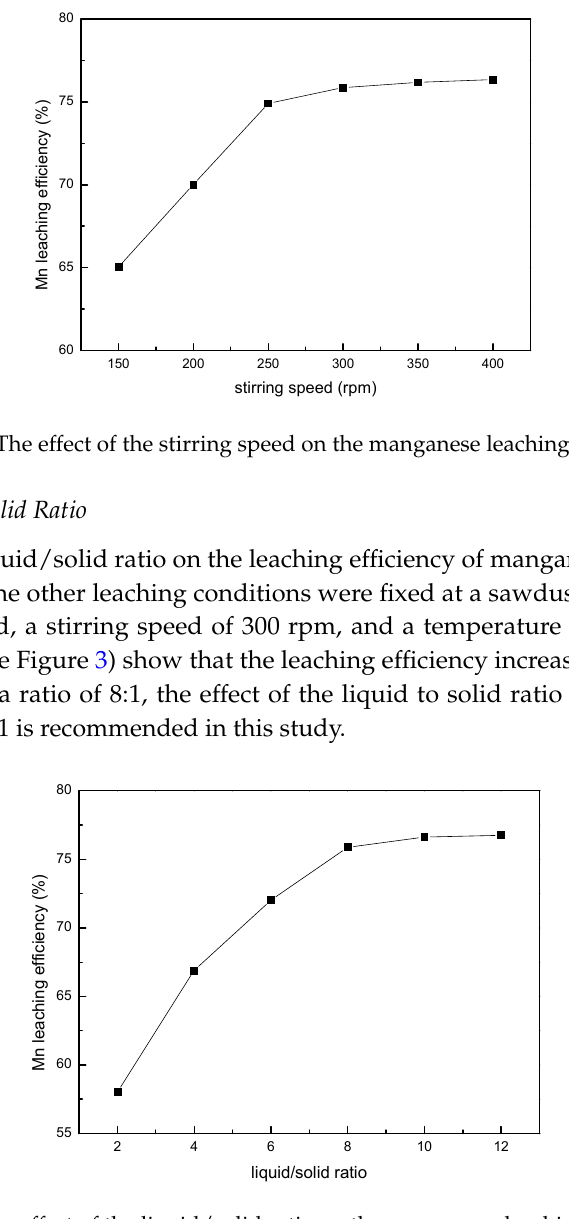
Figure 4. The effect of sawdust/ore mass ratio on the manganese leaching efficiency. 3.4. Effect of the Sulfuric Acid Concentration A series of leaching experiments were performed at different sulfuric acid concentrations of 0.65–1.2 mol/L, and the other conditions were fixed at a sawdust/ore mass ratio of 0.25, a liquid/solid